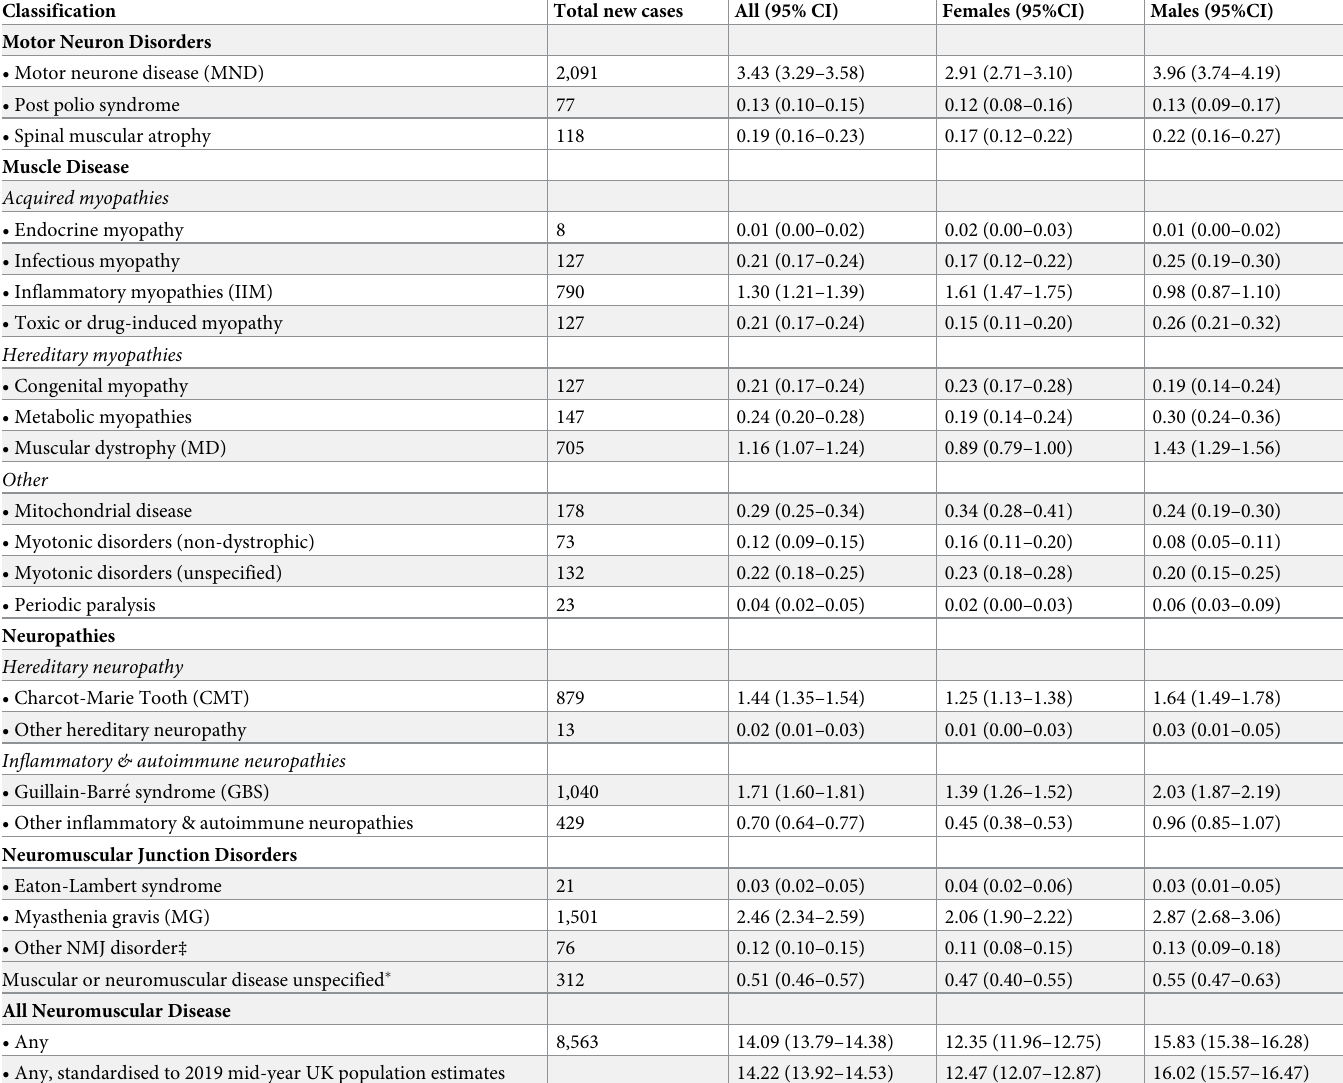
Table 3. Incidence of recorded neuromuscular disease in the UK between